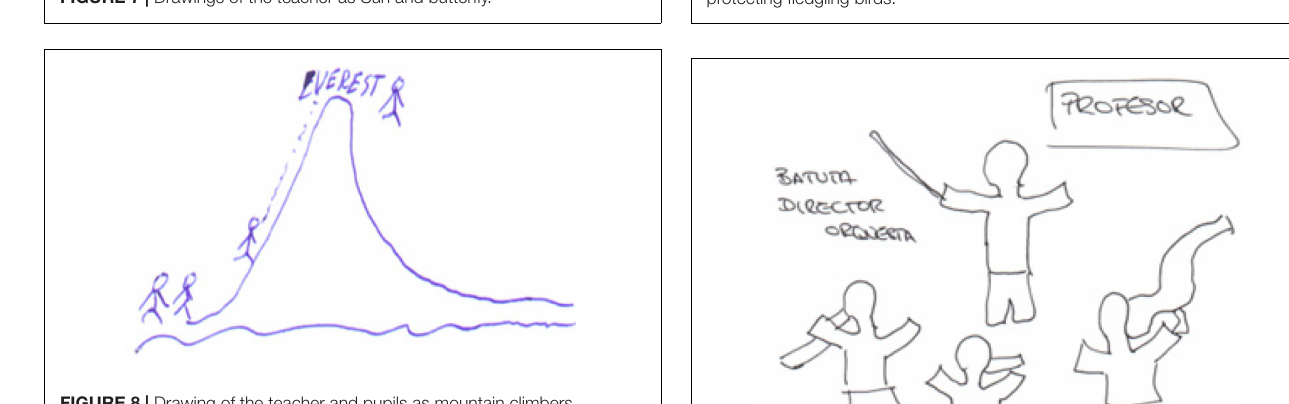
FIGURE 7 | Drawings of the teacher as Sun and butterfly.